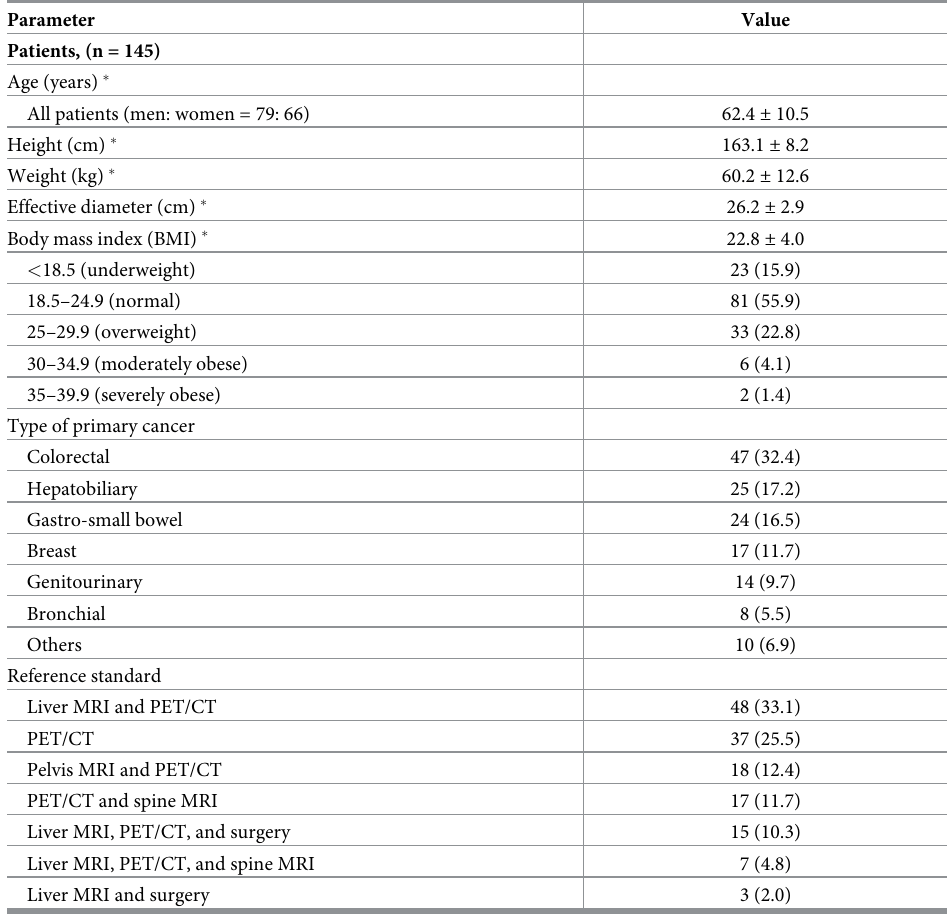
Table 2. Patient